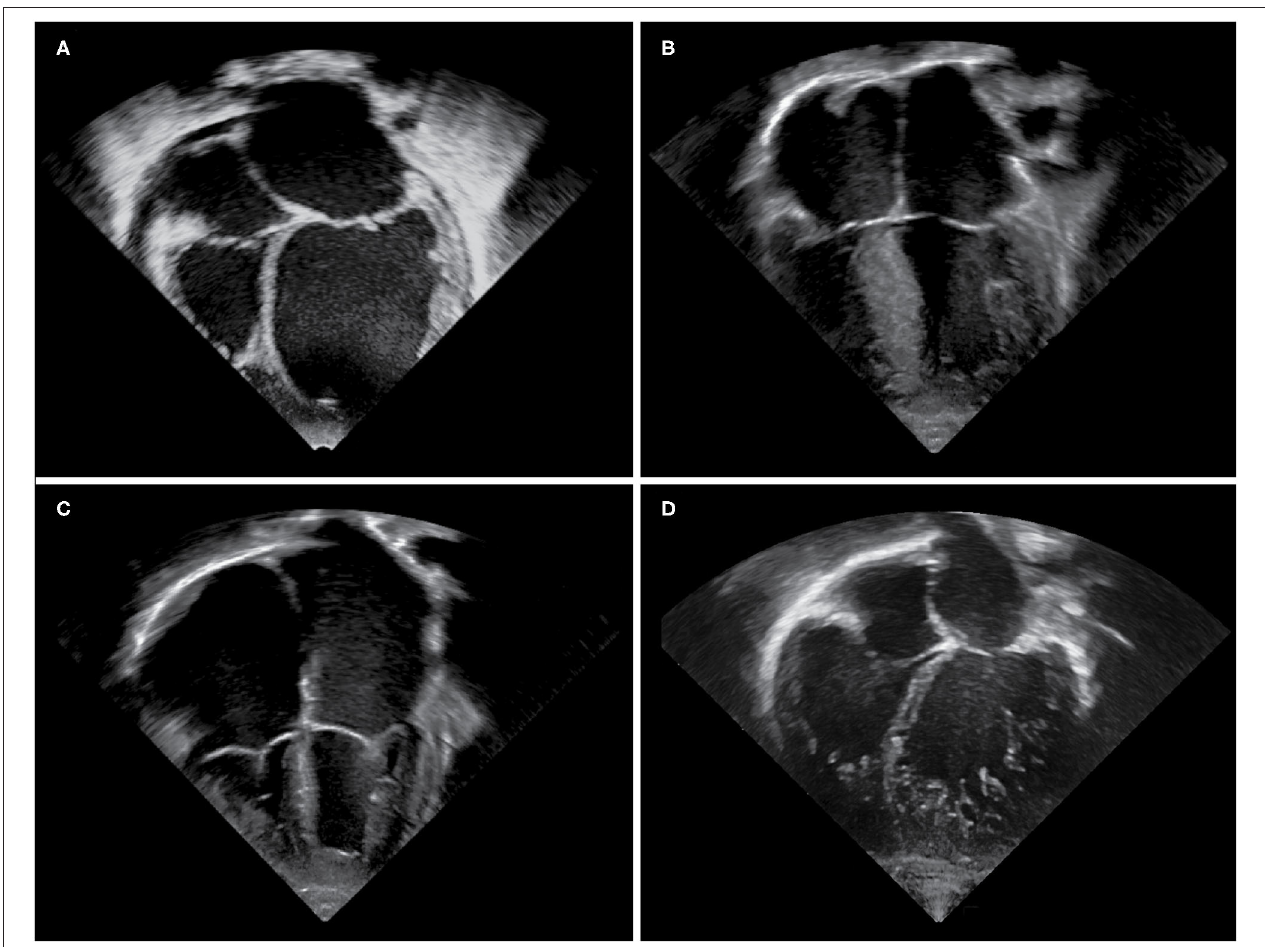
FIGURE 1 | Echocardiographic images of cardiomyopathy phenotypes. Apical four chamber views demonstrating (A) a dilated left ventricle and left atrium in a DCM patient, (B) hypertrophy of the interventricular septum and left ventricular free wall in a HCM patient, (C) massively dilated atria and small right and left ventricular cavities in an RCM patient, (D) an extensively trabeculated myocardium with a compacted and non-compacted layer and deep intertrabecular recesses most prominent at the left ventricular apex and free wall in an LVNC